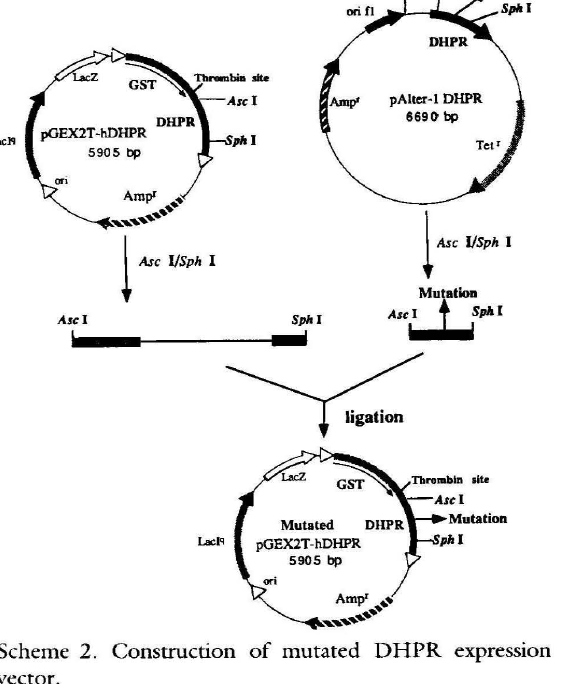
Scheme 2. Construction of mutated DHPR expression vector.